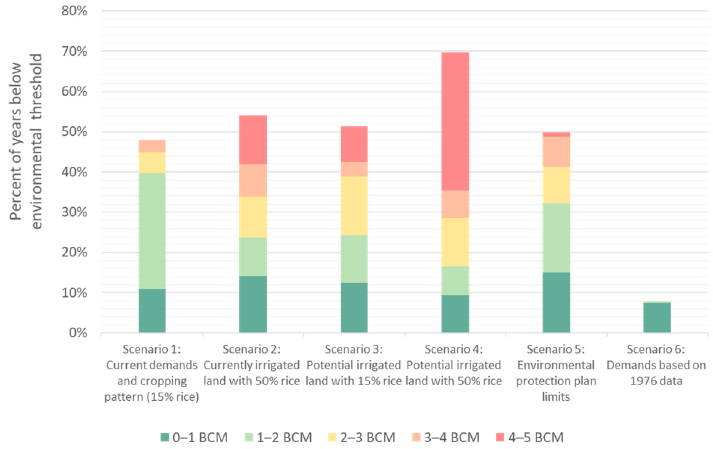
Figure 5. Basin response to the six scenarios representing varying agricultural water demand develop- ment (scenarios AC1–6). Response is explored through reliability of environmental flows and the inten- sity of shortages to the Ili delta. The literature suggests that 11 BCM per year is critical.